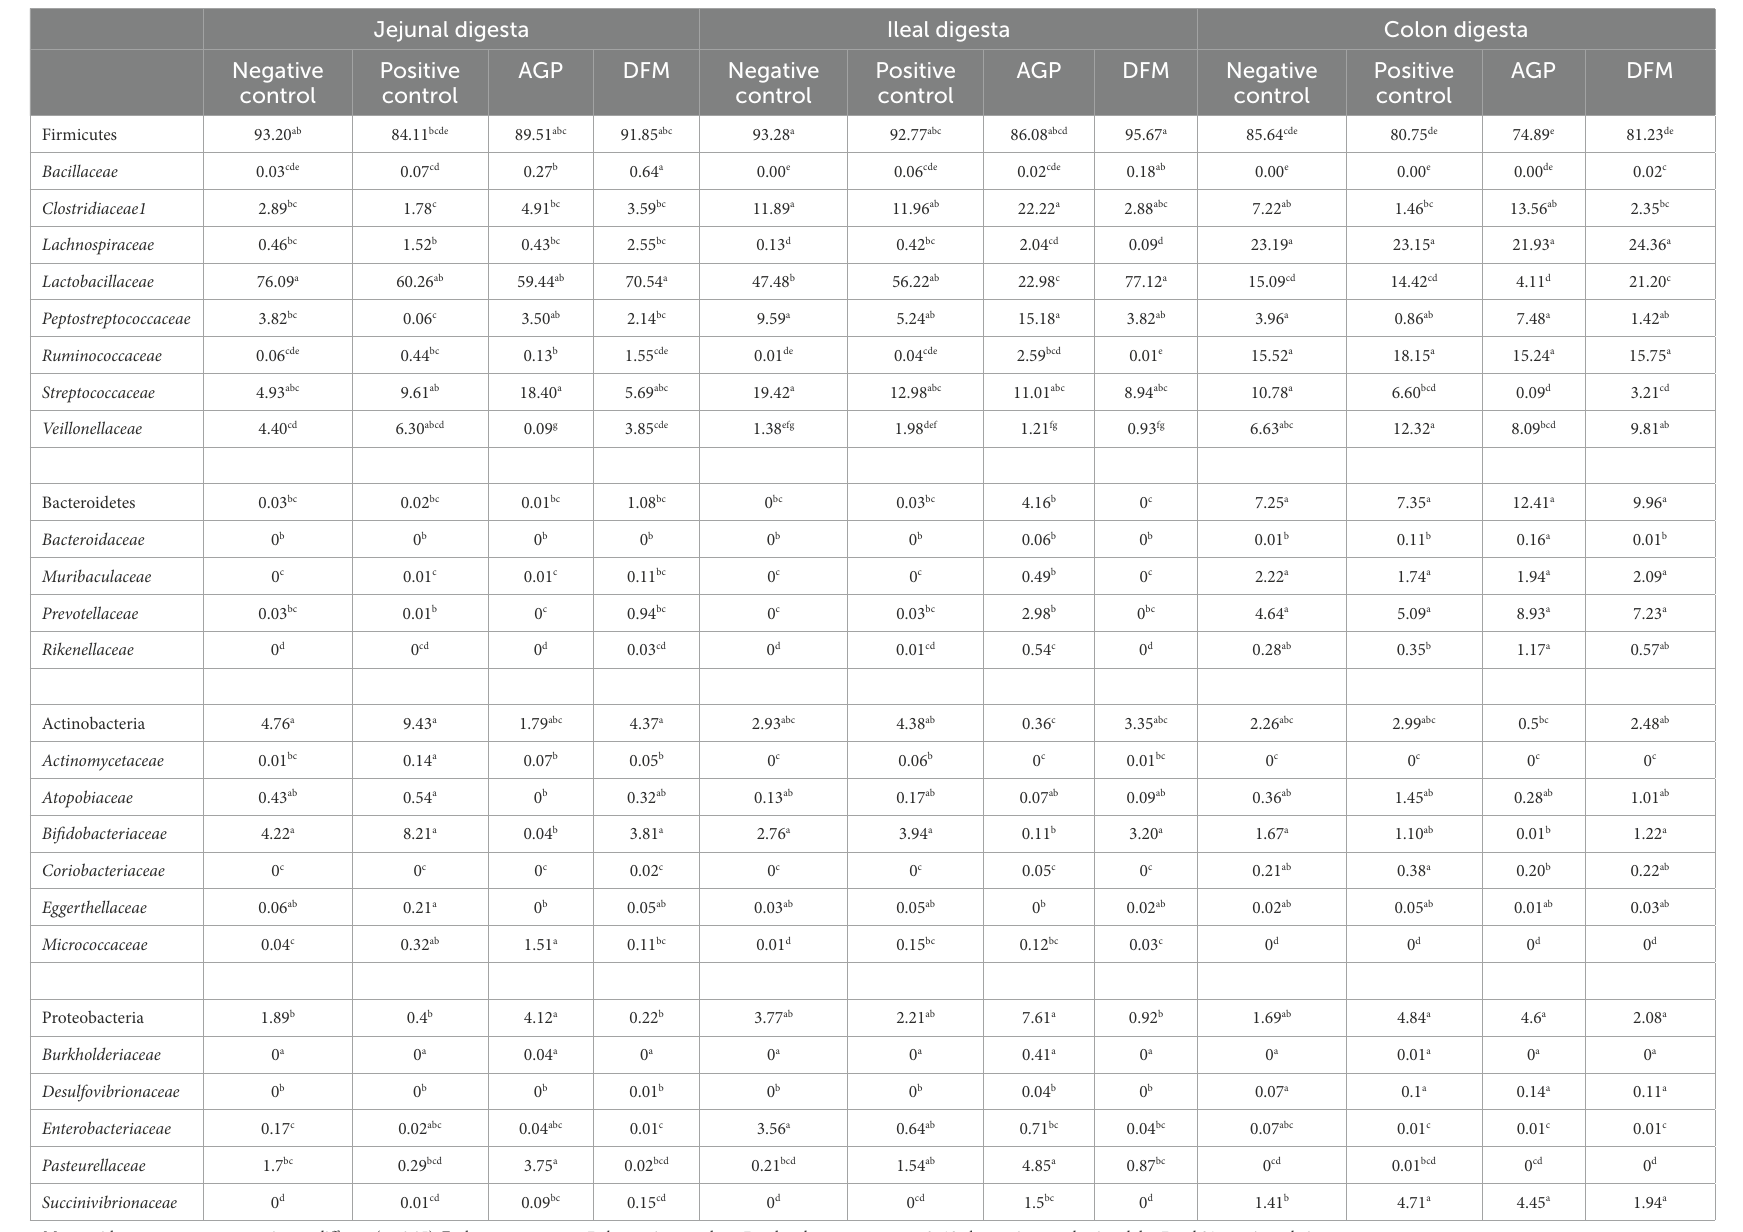
TABLE 3 Relative abundance (%) of Firmicutes, Bacteroidetes, Actinobacteria, and Proteobacteria and their top families in intestinal digesta of enterotoxigenic E. coli challenged pigs fed diets supplemented with antibiotics (AGP) or B. subtilis